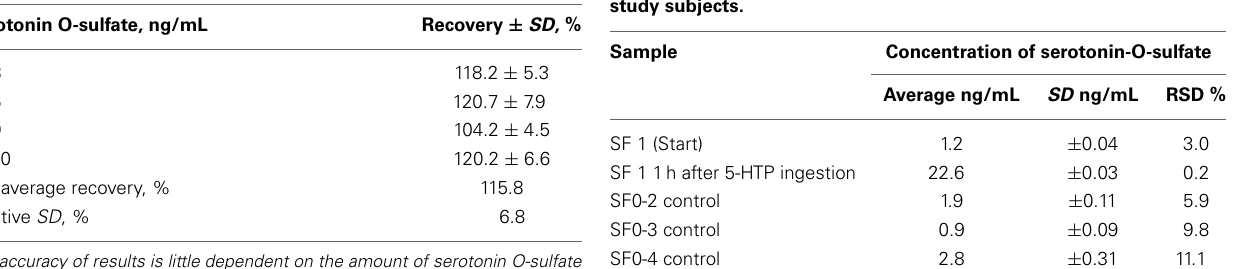
Table 4 | The results of 5-HT-SO4 recovery testing.